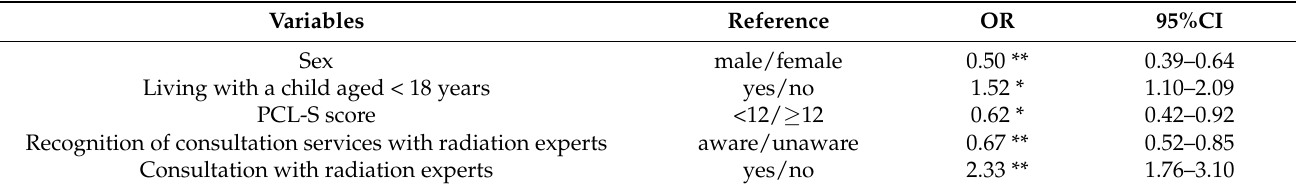
Table 3. Logistic regression analysis for resident anxiety about the health effects of radiation